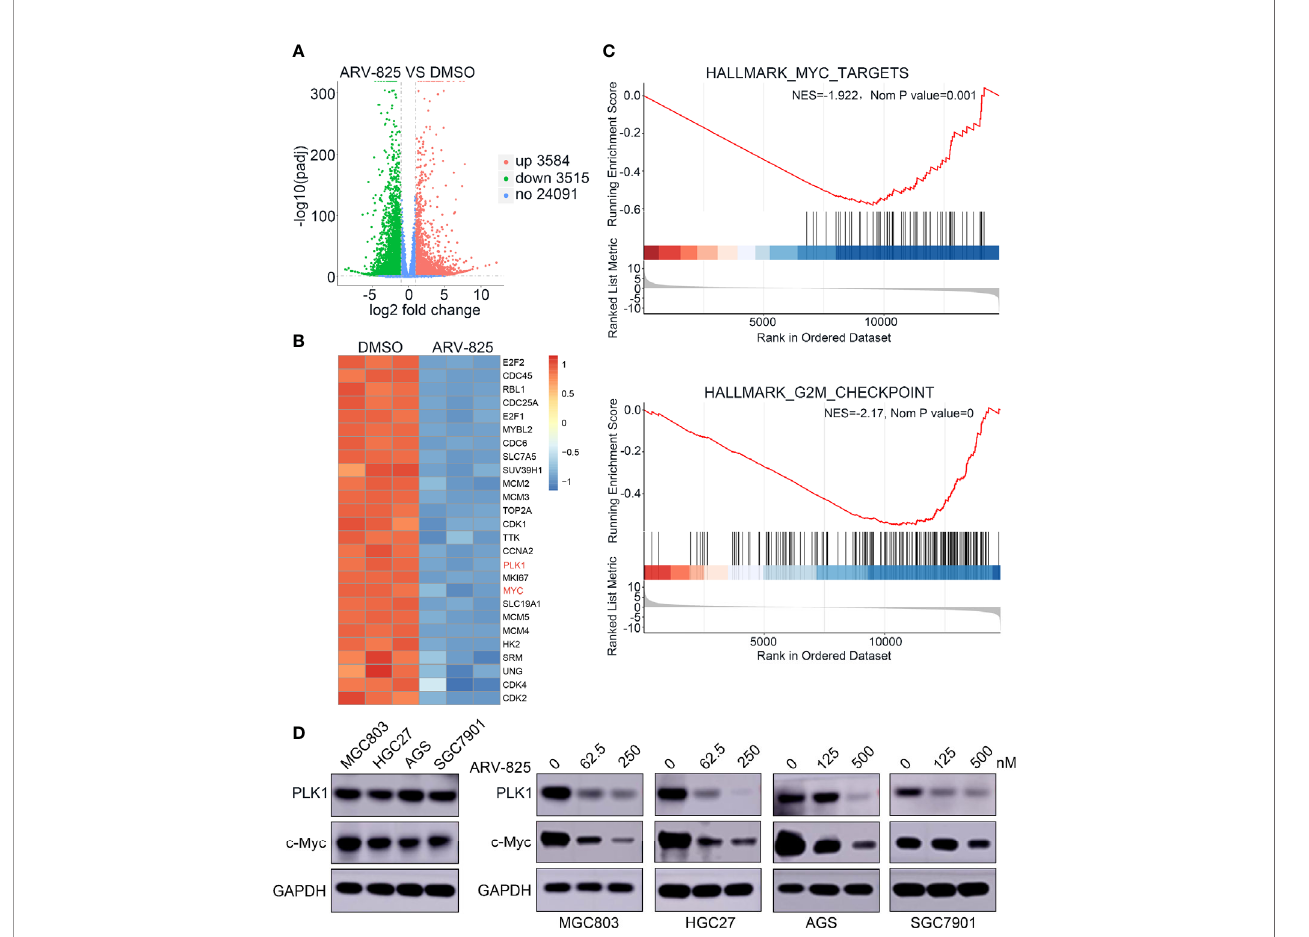
FIGURE 7 | ARV-825 decreases MYC and PLK1 expression in gastric cancer cells. (A) Volcano plot analysis of the RNA-seq illustrated expression changes of genes in HGC27 cells between ARV-825 treatment group and the control group. Genes highlighted in red were upregulated, and those in blue were downregulated; black indicates unchanged expression. (B) Heat-map view displayed the genes of differential expression in HGC27 cells treated with 125 nM ARV-825 (|log 2 fold change> 1, p < 0.05); these genes included c-Myc and PLK1 targets. Each column indicates a sample; each row indicates a gene, The color changes with different expression of each gene. Blue represents downregulation; red represents upregulation. (C) GSEA plots displayed gene enrichment in HALLMARK_MYC_TARGETS and HALLMARK_G2M_CHECKPOINT signaling pathways in HGC27 cells treated with ARV-825. (D) PLK1 and c-Myc protein levels were decreased by ARV-825 treatment in MGC803, HGC27, AGS, and SGC7901